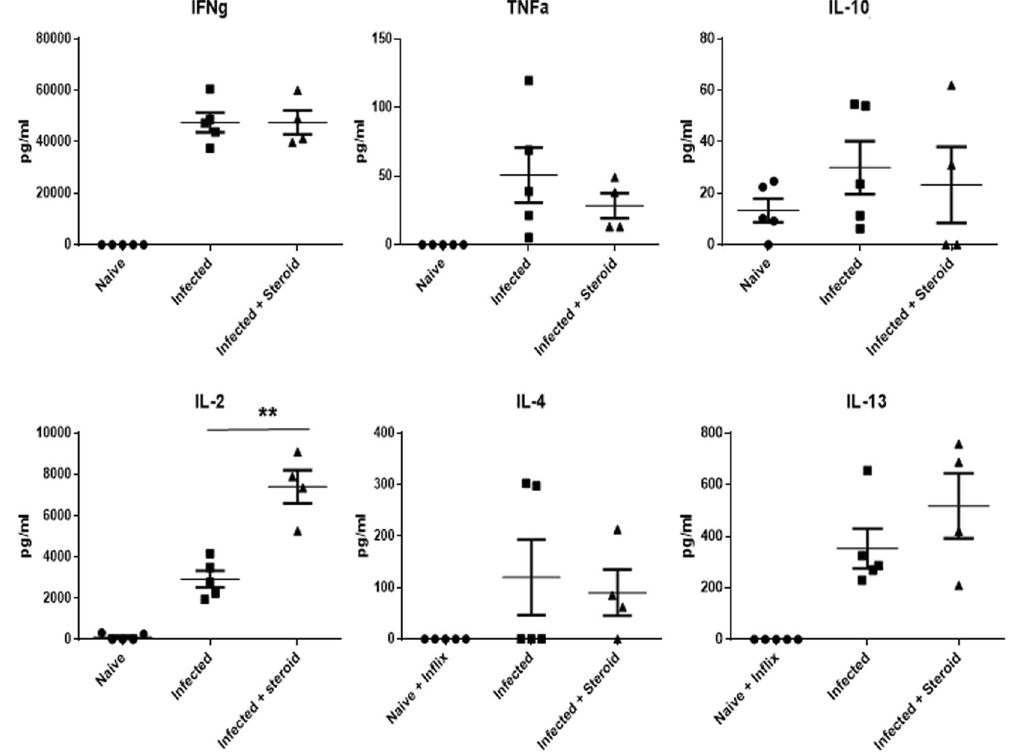
Figure 3. Hydrocortisone treatment significantly upregulated antigen specific IL2 production. Mesenteric lymph node (MLN) cytokine profiling in response to T . muris infection and steroid treatment. MLN cells were stimulated in vitro with T . muris specific E/S-antigen for 24 hours. The supernatant was analysed by cytokine bead array. IL-2 (p = 0.003) was significantly elevated after steroid therapy. Data are expressed for individual mice, and as mean value ± SD (n = 5 Naïve and Infected groups, n = 4 Infected + Steroid